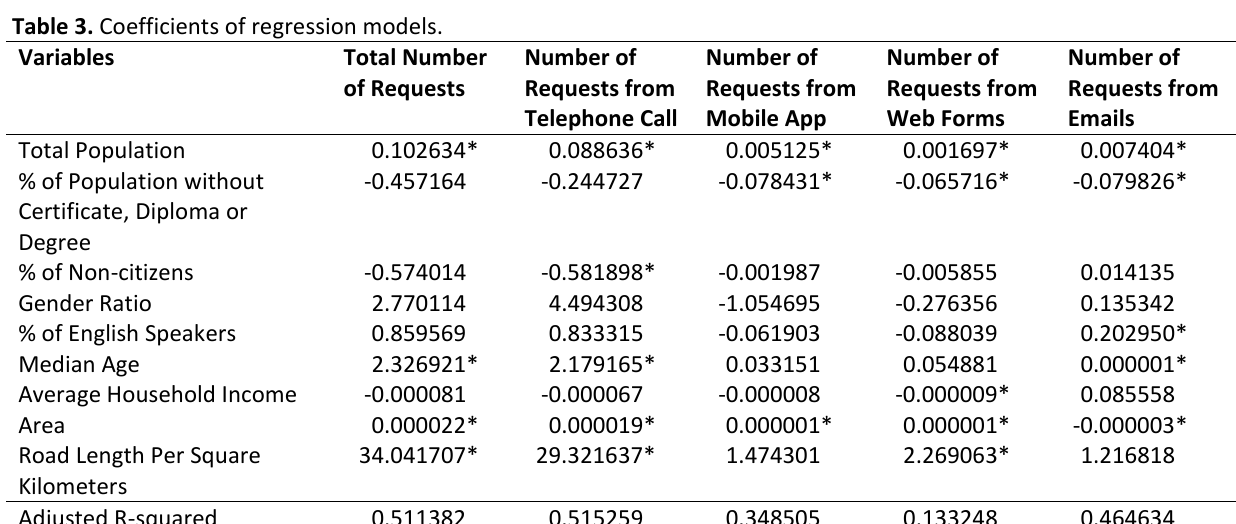
Table 3. Coefficients of regression